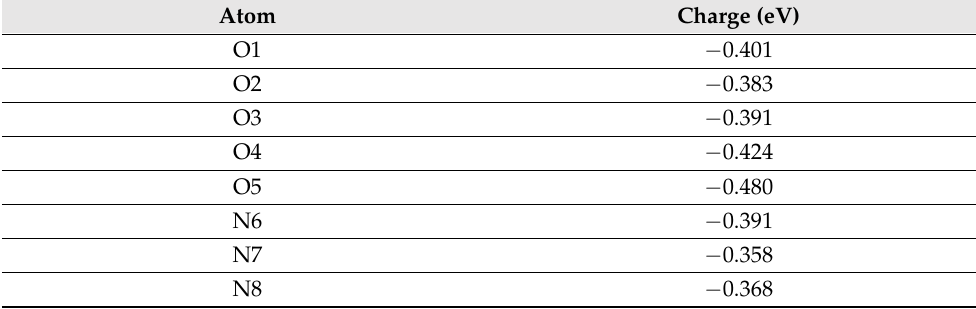
Table 1. The distribution of charges on each atom (position) in the MTX molecule.